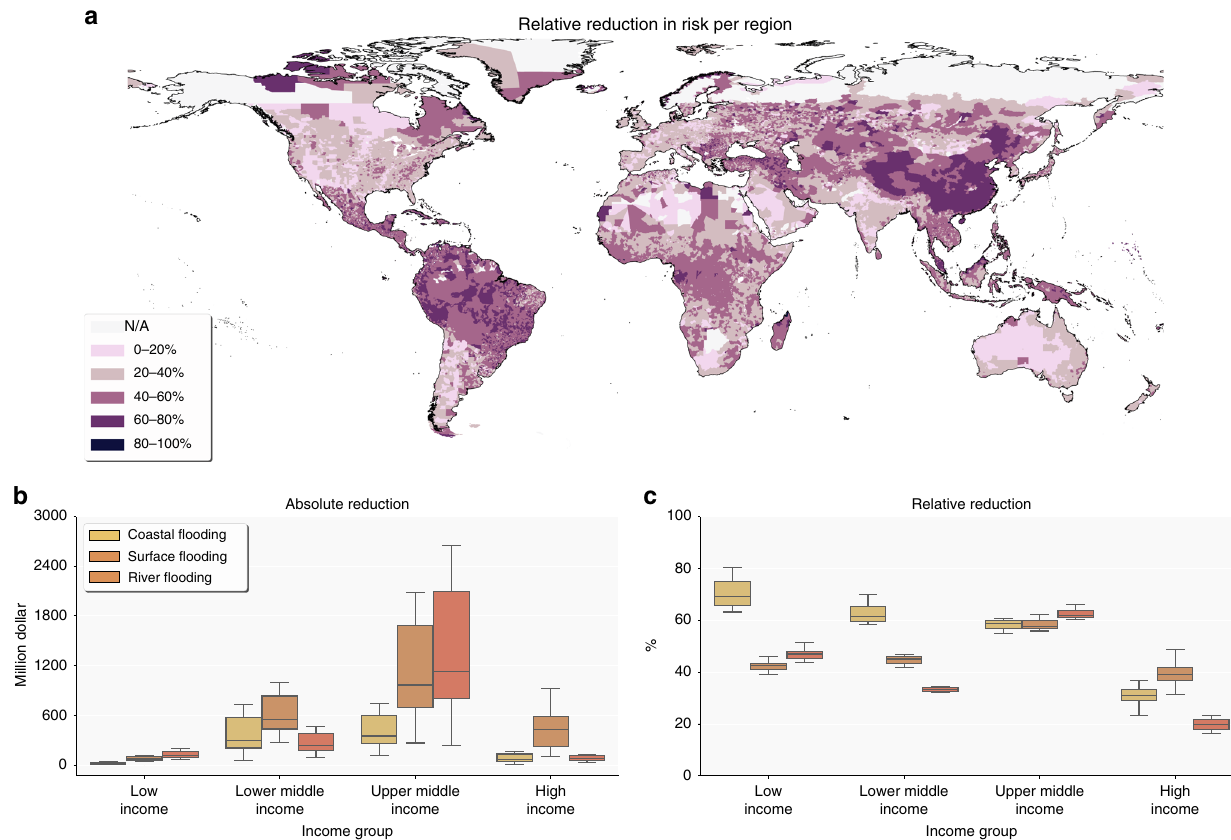
Fig. 6 Risk reduction due to fl ood design-standard upgrades. Panel a presents the total combined reduction in EAD per region. Panel b presents the absolute reduction in EAD for coastal, surface and river fl ooding. Panel c presents the relative reduction in EAD for coastal, surface, and river fl